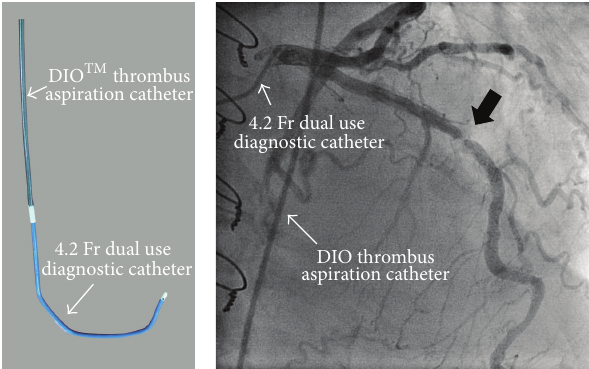
Figure 2: Left coronary artery angiography supported DIO throm- bus aspiration catheter. A 4.2 Fr dual use catheter was inserted into the DIO thrombus aspiration catheter. Selective injection revealed 99% stenosis at the midportion of the left anterior descending artery.